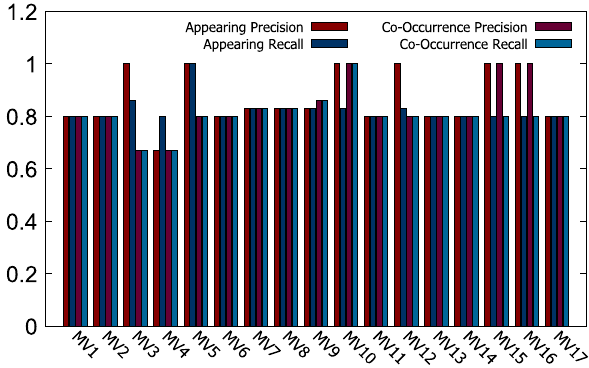
Fig. 6 Minor characters’ precision and